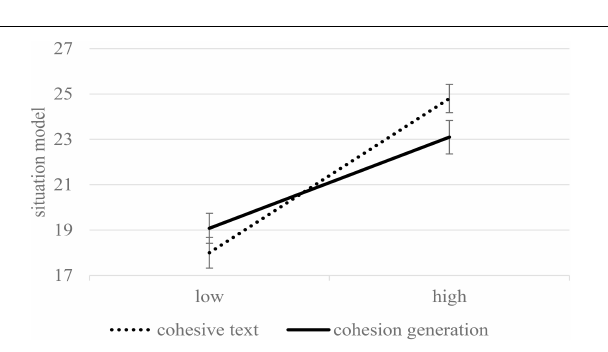
FIGURE 2 | The situation model as a function of condition and delay when controlling for reading skills (estimated means and standard errors). Maximum performance was 42.